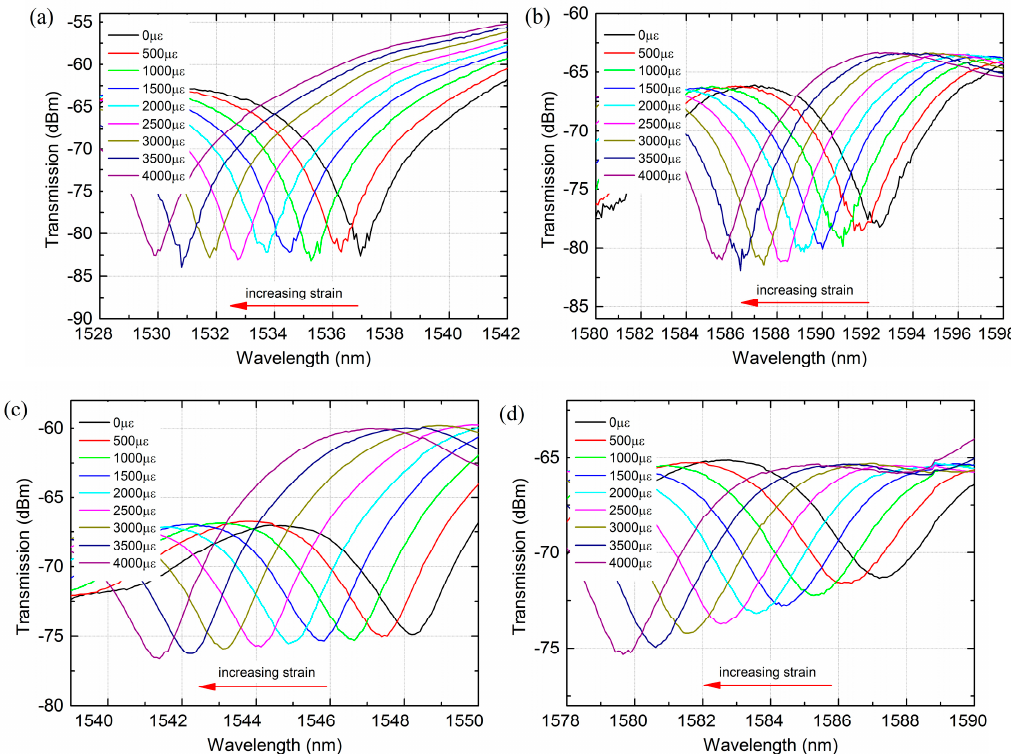
Figure 6. Transmission spectra change as the strain increases: ( a ) 1536 nm dip of the MZI with 35 mm PCF; ( b ) 1592 nm dip of the MZI with 35 mm PCF; ( c ) 1548 nm dip of the MZI with 40 mm PCF; ( d ) 1587 nm dip of the MZI with 40 mm PCF.